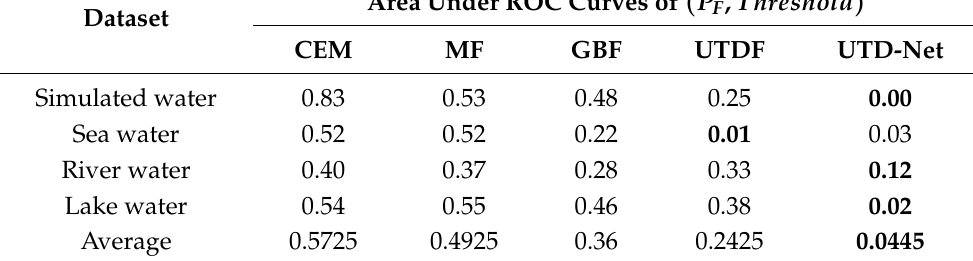
Table 6. The AUC values of ( P F , Treshold ) of underwater target detection results for compared methods on all